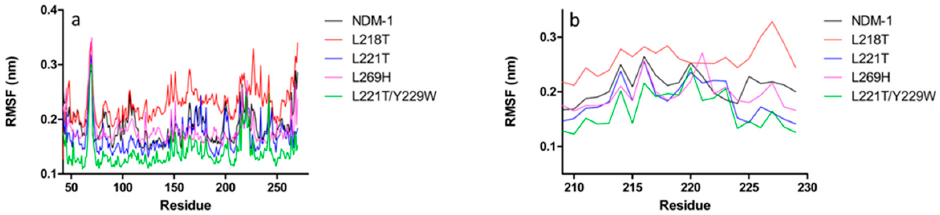
Figure 1. Comparison of C α -atoms residual fluctuation of wild-type and mutant systems: ( a ) of all residues and ( b ) of just loop 10 residues (209–229).